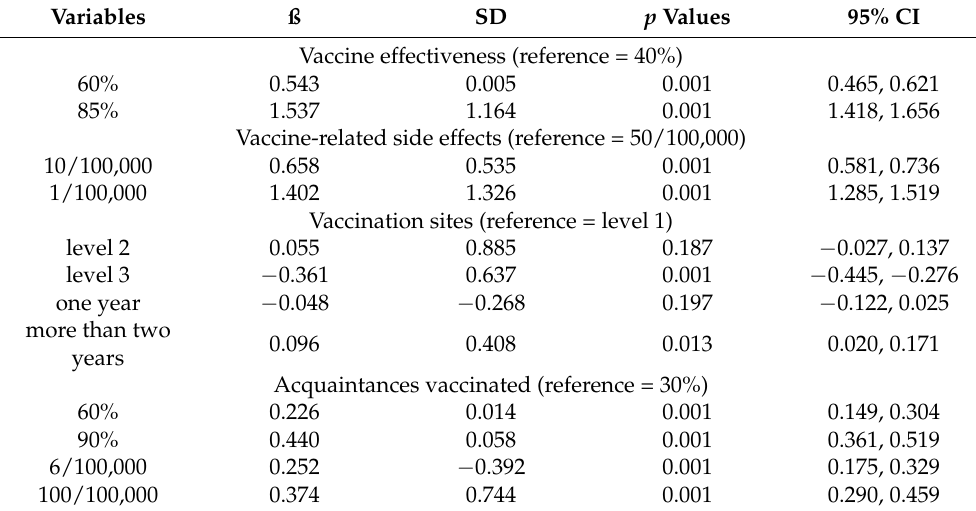
Table 5. Mixed Logistic Regression Models of Patient